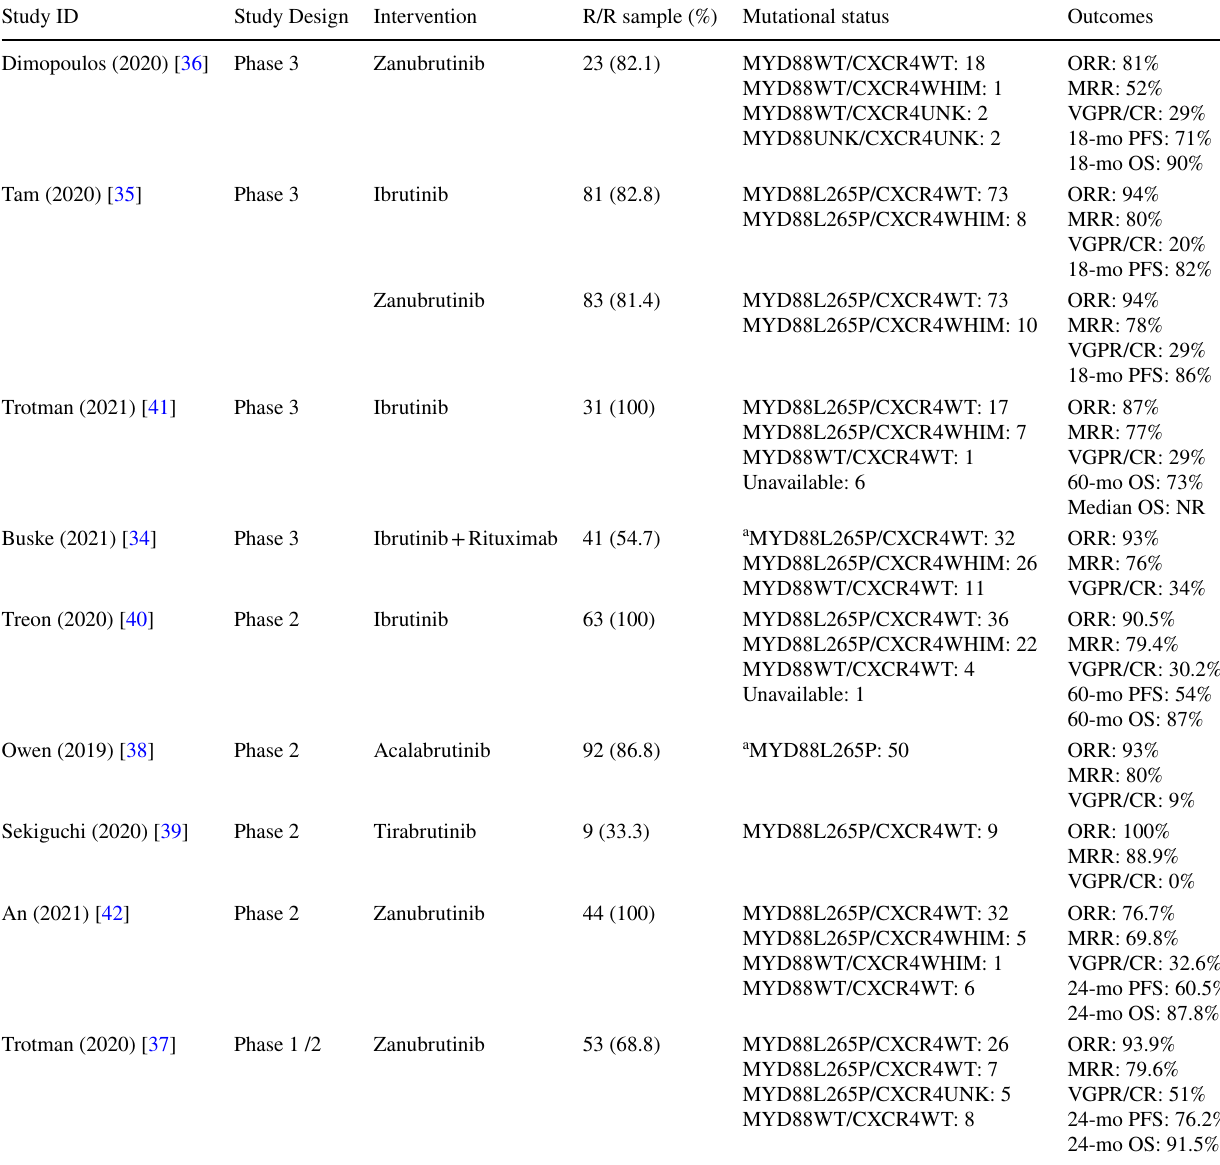
Table 2 Characteristics and outcomes of clinical trials using BTKi in relapsed/refractory settings in WM